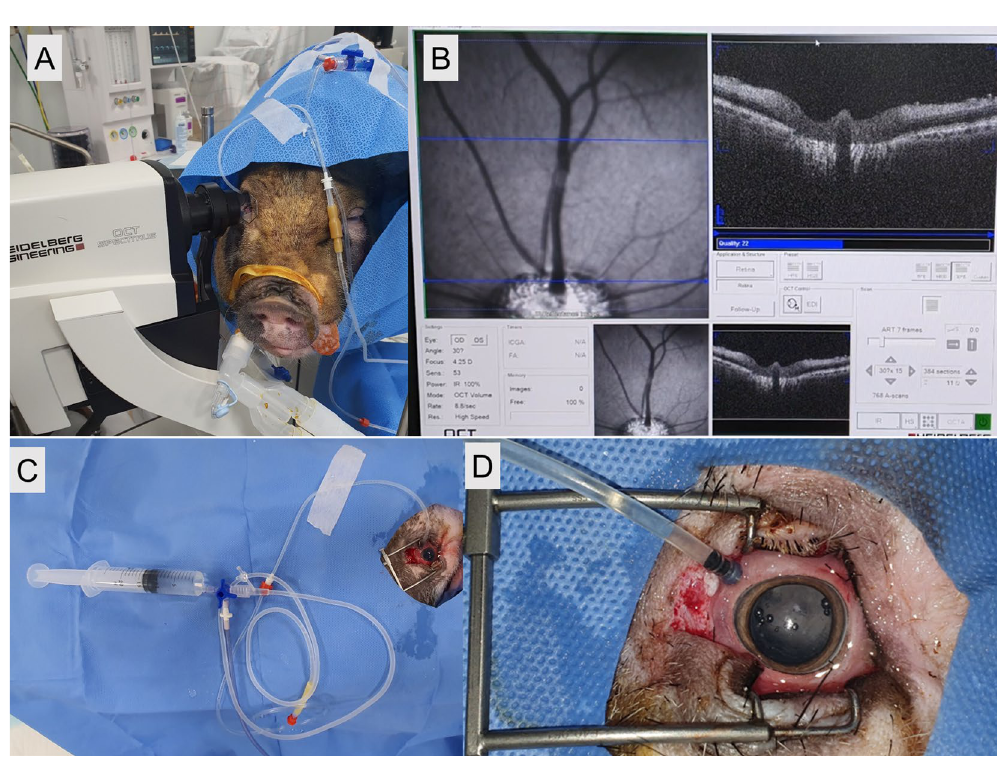
Figure 6. The experimental procedures. ( A ) The vitrectomy was performed in the decubitus position and pig was positioned to lay straight for OCTA imaging. A ventrolateral infusion was maintained and connected to the vented-gas forced-infusion system. ( B ) The position of the eye during OCTA image capture. The optic nerve head was maintained in the lower center of the fundus region and visualized with the scanning-laser ophthalmoscopy module. ( C , D ) Tissue fixing procedure. The zinc formalin fully filled the eye and continuous pressure was supplied by the VGFI